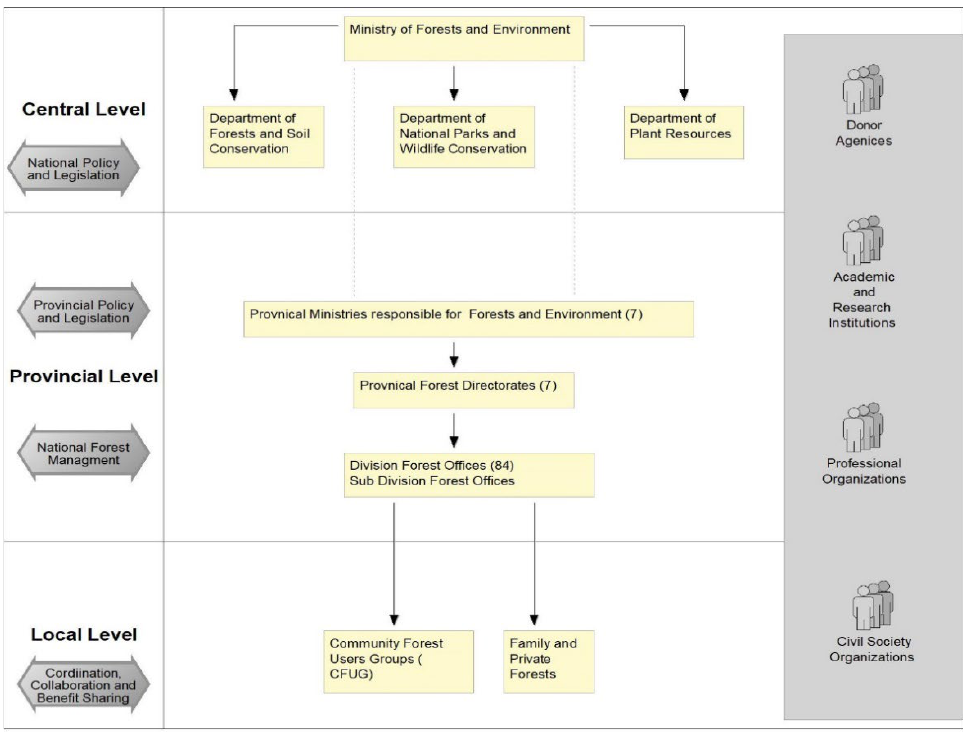
Figure 1. Organizational structure for forestry sector in Nepal (dotted lines suggest only a policy subordination , no operational subordination) .